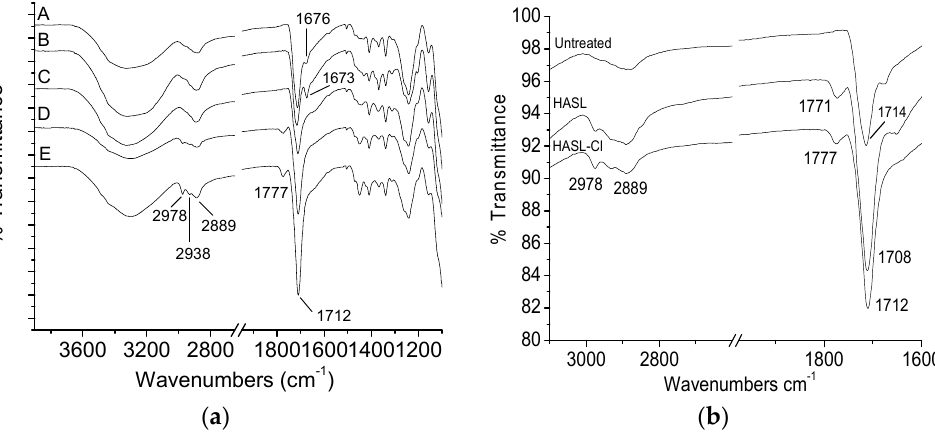
Figure 2. Fourier Transform Infrared (FTIR) specta of untreated and N-halamine treated wound dressings. ( a ) FTIR spectra of A: untreated, B: MC-treated, C: Hy-Ep-Cl-treated, D: BA-1-Cl-treated and E: HASL-Cl-treated dressings (spectra taken after chlorination of Hy-Ep, BA-1 and HASL-treated wound dressings); ( b ) FTIR spectra of untreated, HASL-treated and HASL-Cl-treated dressings.